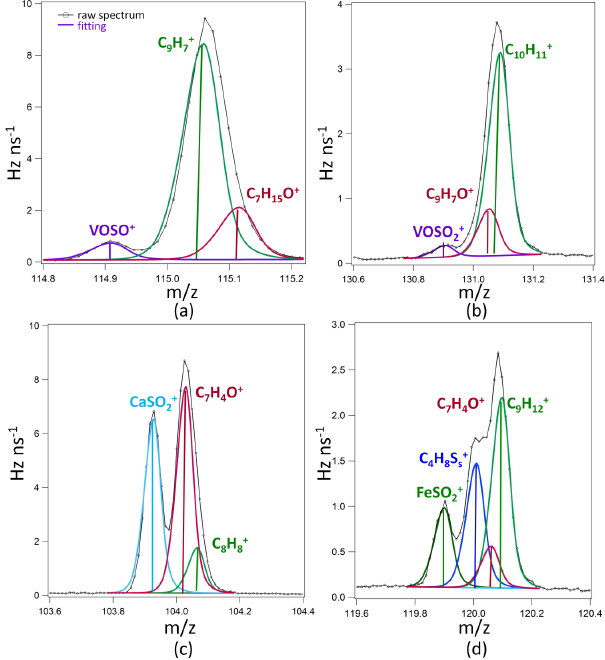
Figure 6. Average high-resolution mass spectra for the m/z 115 (a) , 131 (b) , 104 (c) and 120 (d) during the field experiment at the heating